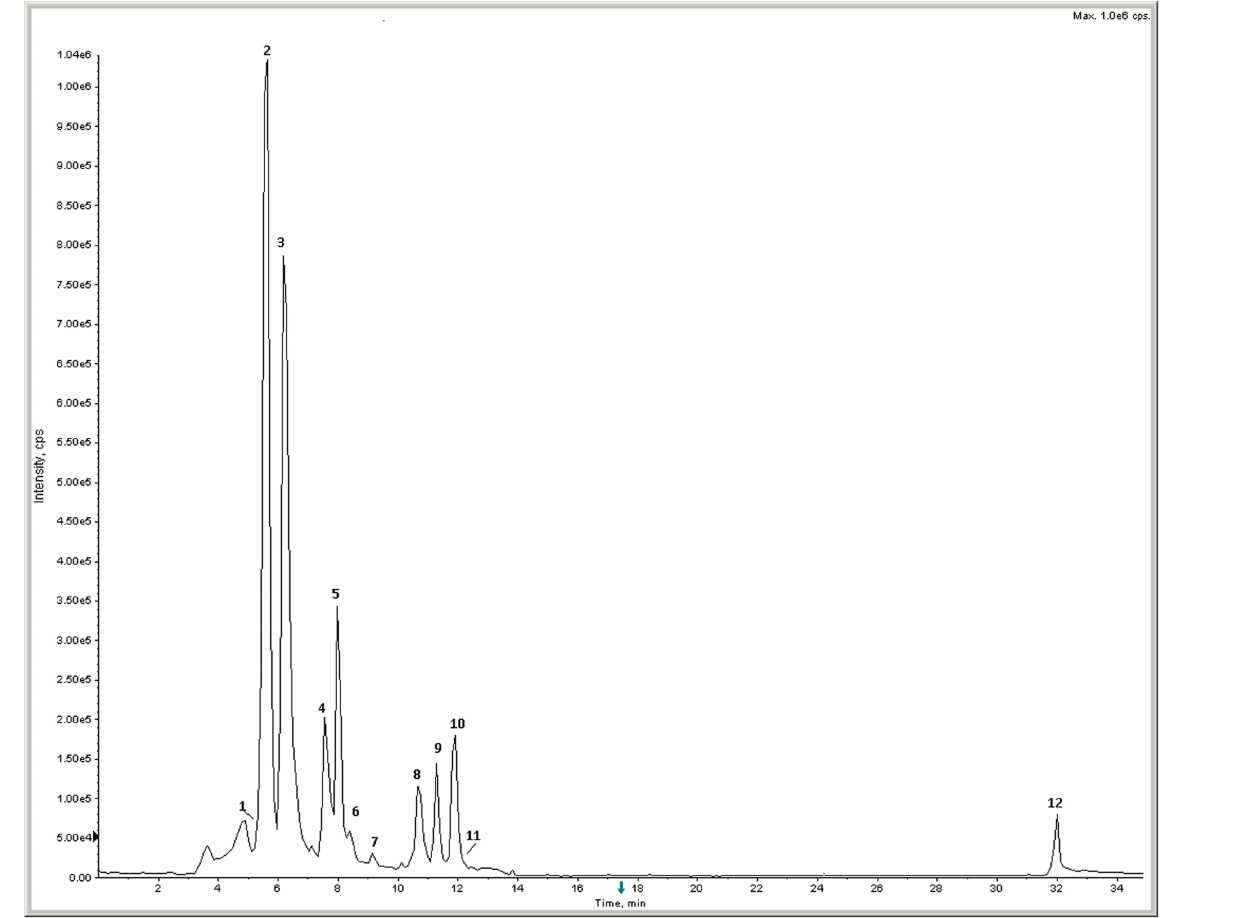
Fig 1. Total Ion Chromatogram (TIC) of rosemary extract. Numbers refer to compounds listed in Table 1. doi:10.1371/journal.pone.0132439.g001 Table 1. List of metabolites occurring in the Rosmarinus officinalis extract identified by LC MS/MS.